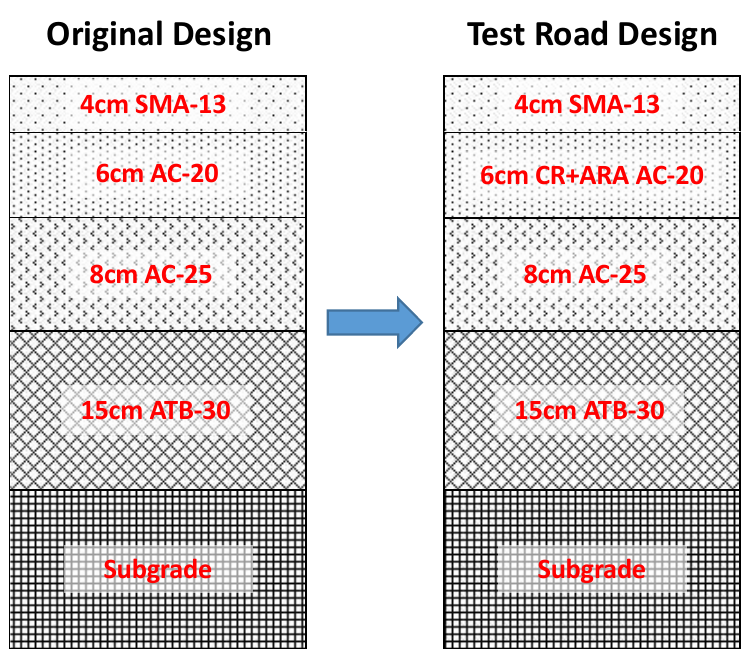
Figure 3. Cross-sections of the road structure: the original designed AC-20 in the middle layer was replaced by CR-modified anti-rutting AC-20.